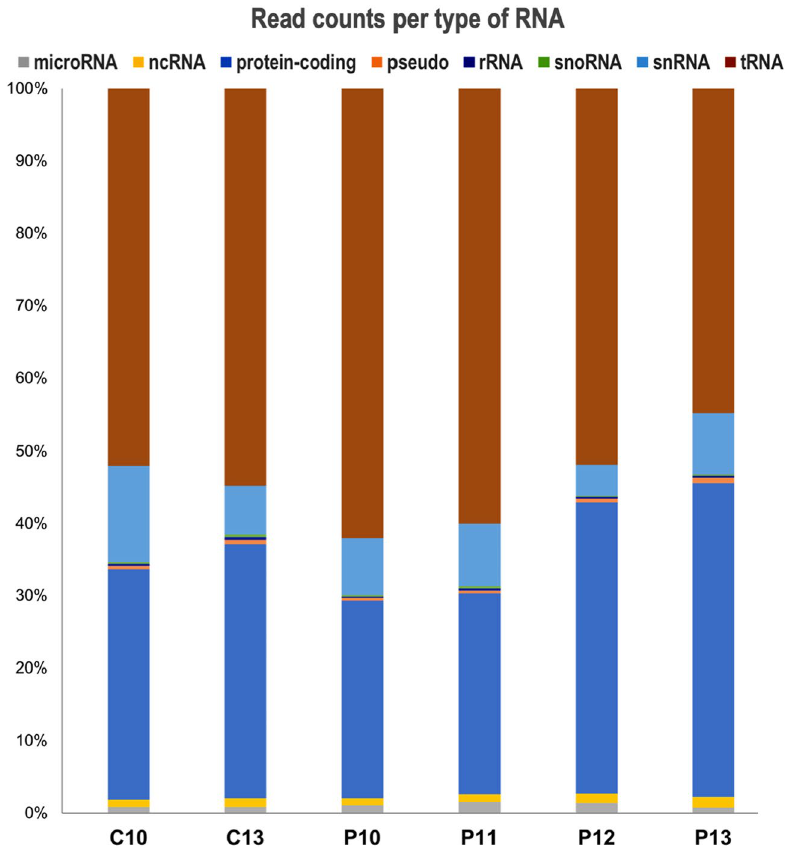
Figure 2. RNA type distribution for uterine EVs RNA cargo across days of pregnancy and estrous cycle. Bar graph shows the percentage of reads attributed to each RNA type per cycle days 10 and 13 (C10- C13) and pregnancy days 10 to 13 (P10-P13). Image created with Microsoft Excel for Mac v.16.59 and modified with Adobe Photoshop